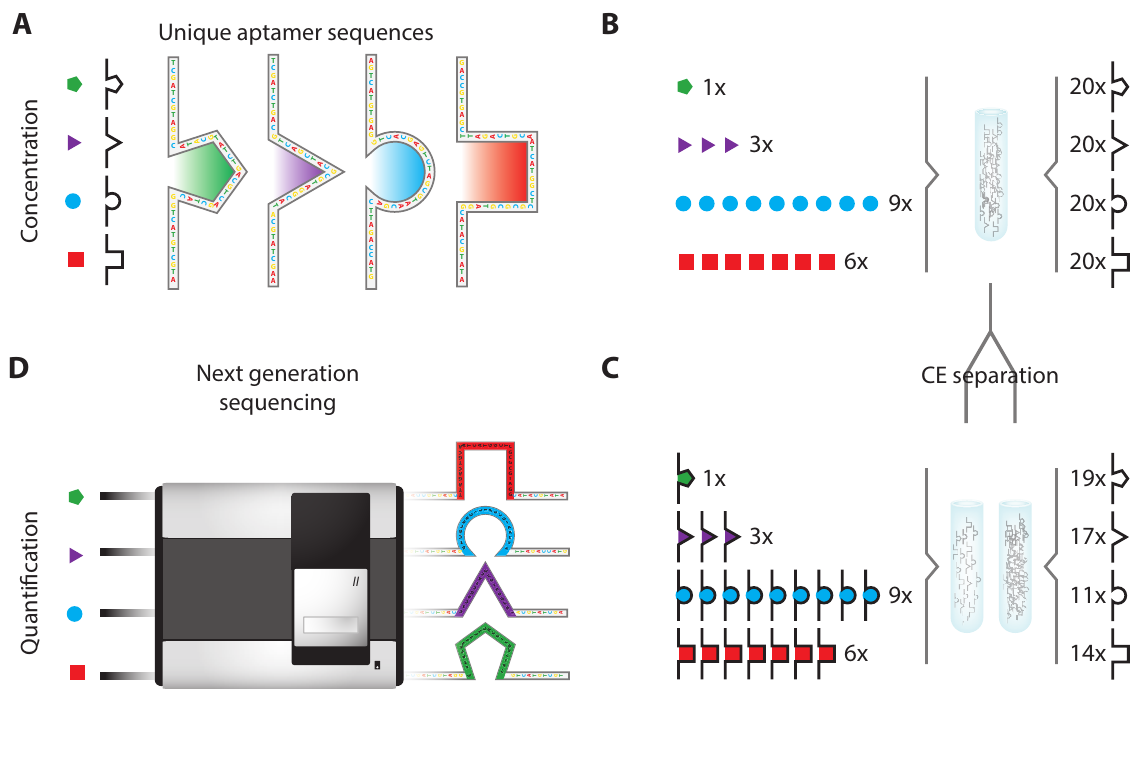
Figure 19. The application of NGS to protein diagnostics: An aptamer collection containing an excess of aptamers with established affinities against the analytes of interest ( A ) is used to incubate the sample under investigation ( B ). All different aptamer-analyte complexes are separated from the excess (unbound) aptamers ( C ) after which the bound aptamers are analyzed by NGS ( D ). The analytes of interest are then identified and quantified by decoding and counting the nucleotide sequences of their respective aptamers